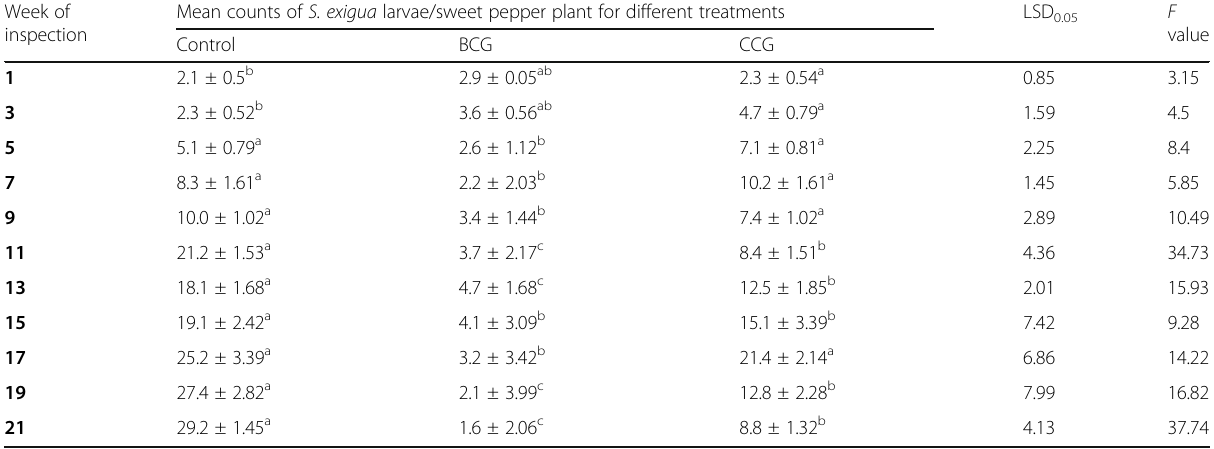
Table 5 Mean counts of S. exigua larvae/sweet pepper plant in greenhouse during the winter plantation 2016 – 2017 Week of Mean counts of S. exigua larvae/sweet pepper plant for different inspection